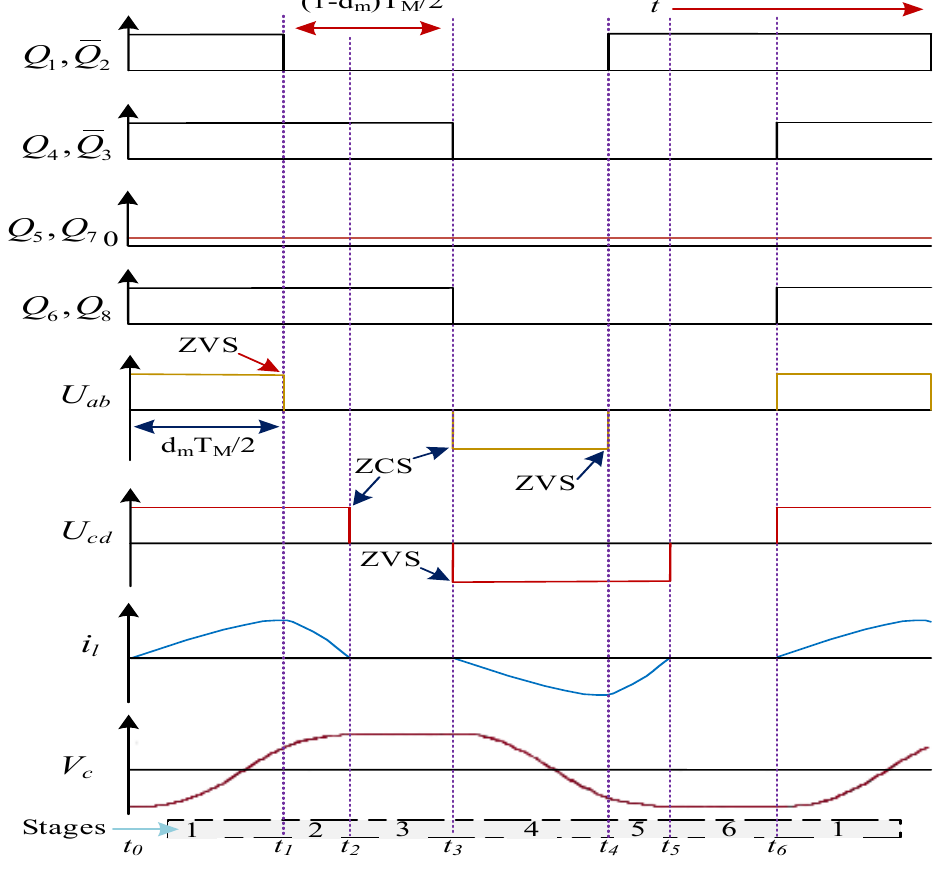
Figure 2. Suggested converter waveforms under FFM.